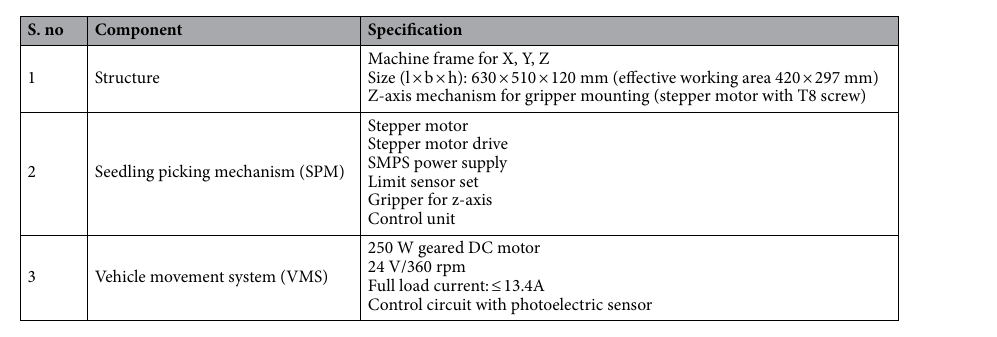
Table 1. Specification of the developed robotic